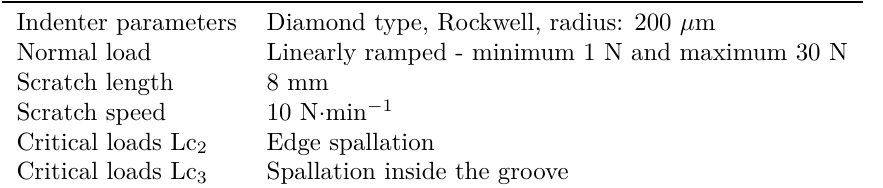
Table 2. Scratch test